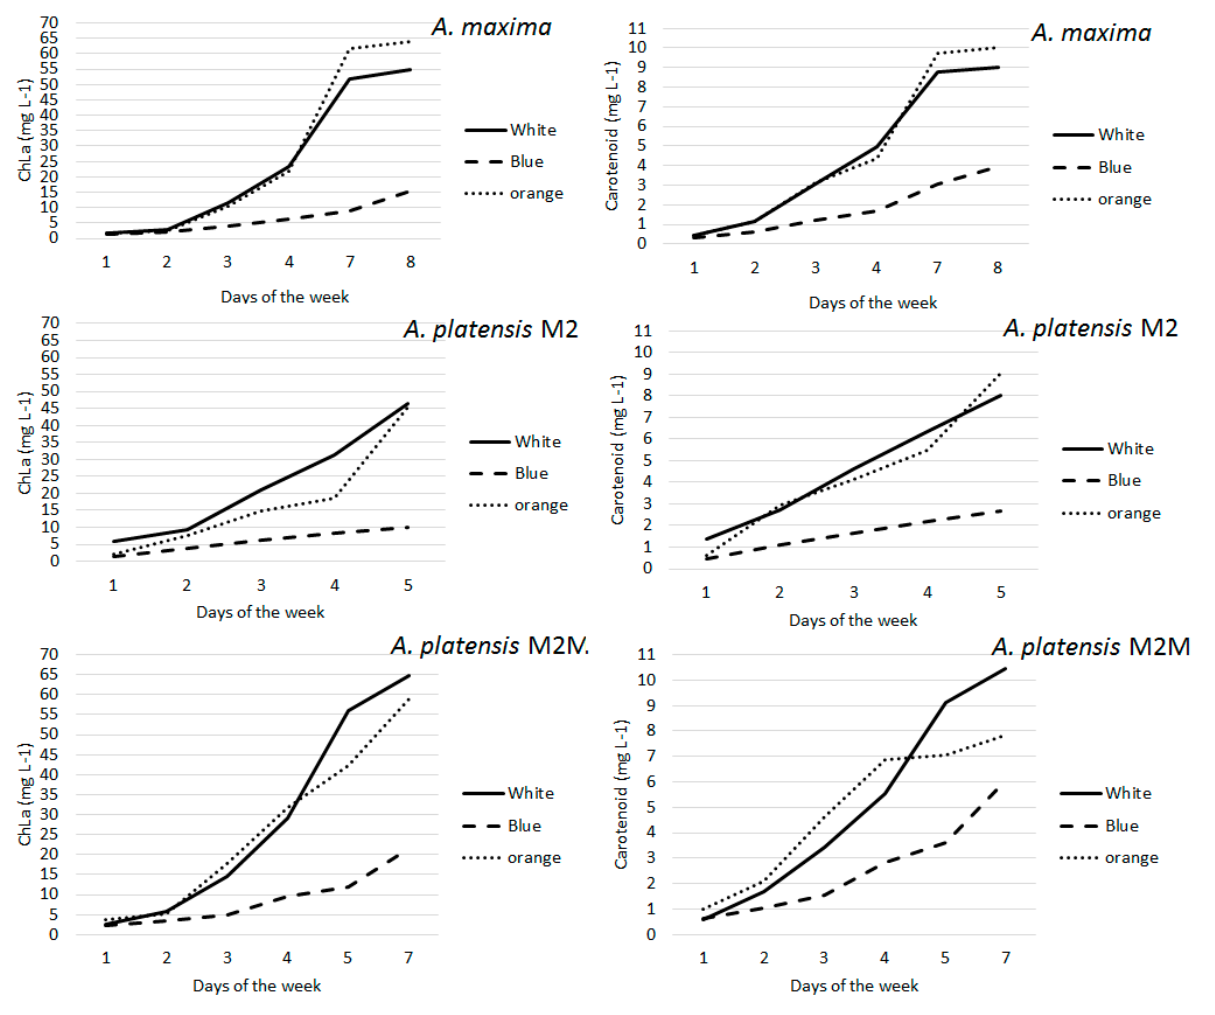
Figure 2. Chlorophyll a (Chl a ) and carotenoid amounts in different Arthrospira strains following exposure to white, orange and blue lights.